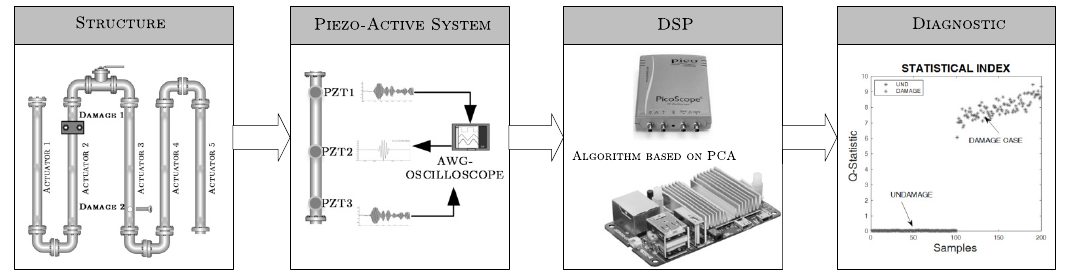
Figure 1. Damage diagnosis system schematic.